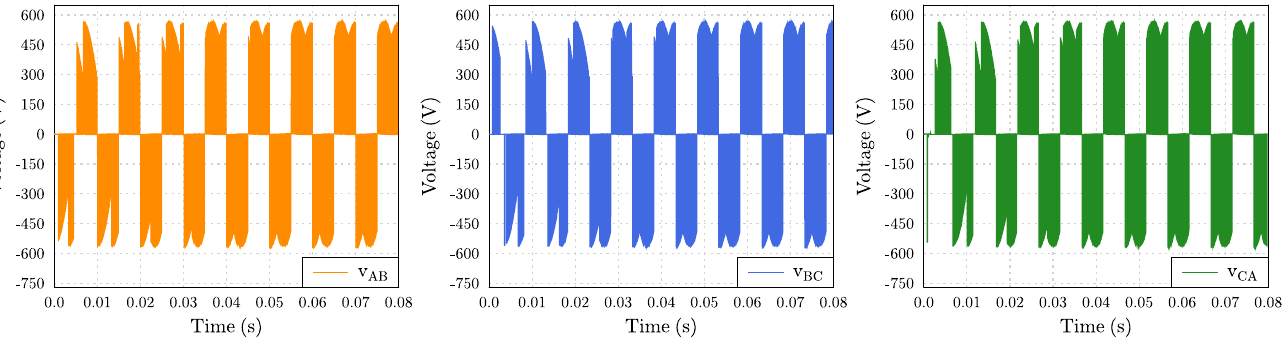
Figure 22. Output line voltages of the IMC controlled by SVM.